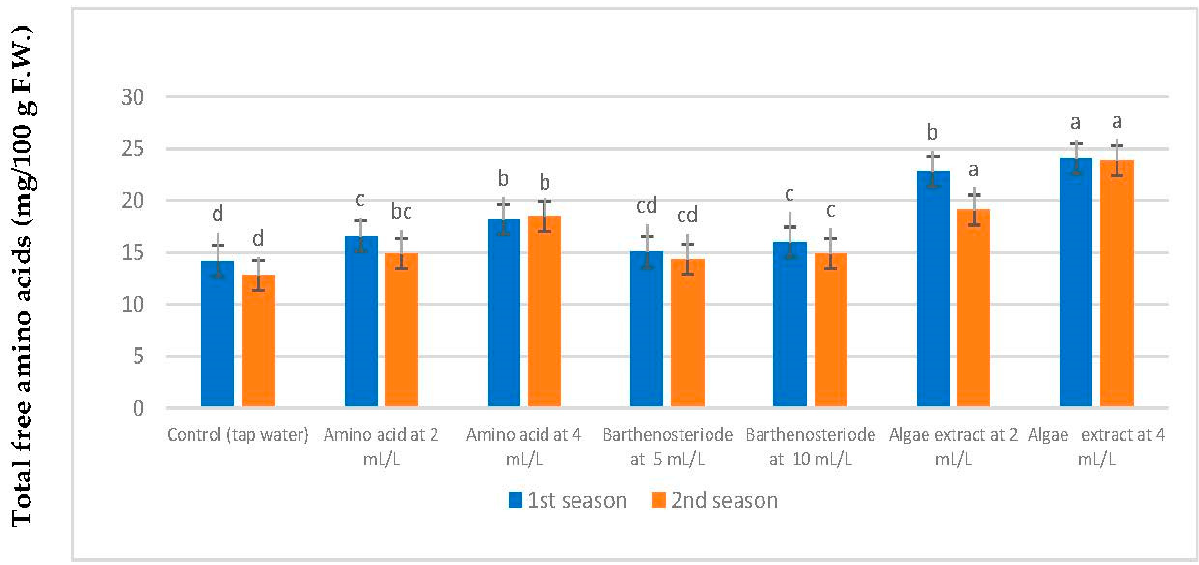
Figure 4. Effect of various bio-stimulant treatments on chia ( Salvia hispanica L.) plant total free amino acids (mg/100 g F.W.) during the 2019–2020 and 2020–2021 seasons. For the same column, means followed by the same letter are not statistically different, according to the Tukey multiple range test.